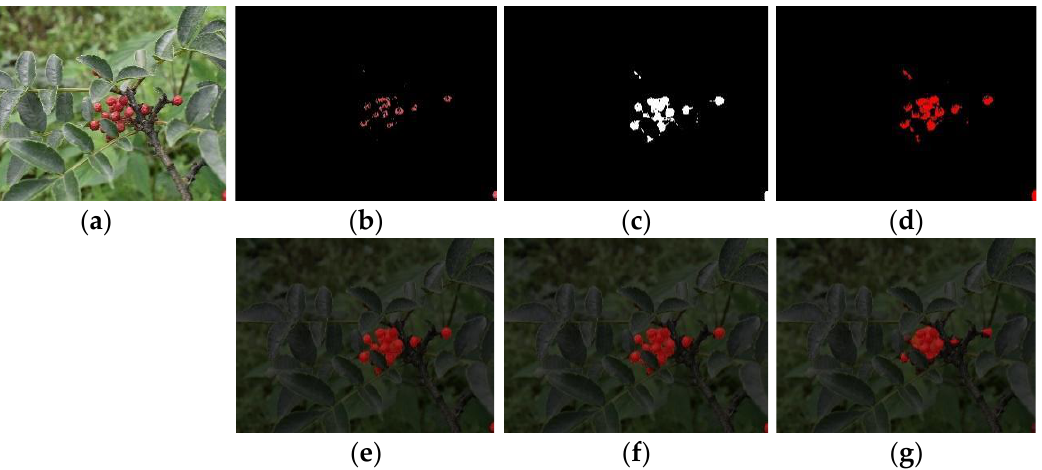
Figure 12. ( a ) Single front-lit cluster with occlusion; ( b ) results from RGB algorithm for segmentation; ( c ) results from HSV algorithm for segmentation; ( d ) results from k-means algorithm for segmentation; ( e ) results from U-Net algorithm for segmentation; ( f ) results from DeepLabV3+ algorithm for segmentation; ( g ) results from PSPnet algorithm for segmentation.